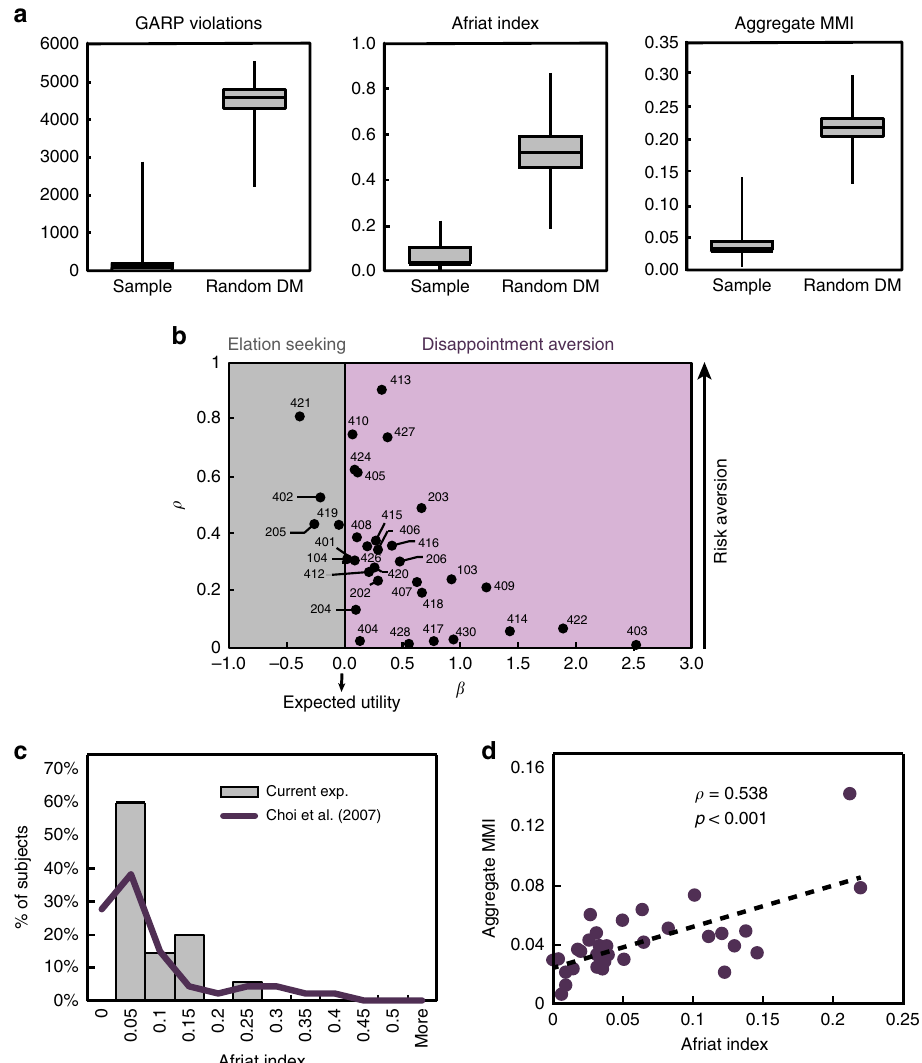
Fig. 3 Behavioral results. a Actual subjects vs. random subjects: In our sample, the median number of GARP violations was 59 (std = 506.24, min = 1, lower quartile = 11, upper quartile = 166, max = 2873), the median Afriat index was 0.0362 (std = 0.058, min = 0.0007, lower quartile = 0.0258, upper quartile = 0.1011, max = 0.2197), and median Aggregate MMI score was 0.037 (std = 0.0242, min = 0.0065, lower quartile = 0.0297, upper quartile = 0.0481, max = 0.143). Both the aggregate MMI and Afriat index range between 0 (fully consistent) and 1. For comparison, 25,000 simulations of random decision-makers yielded median number of GARP violations of 4,568.5 (std 397.6, min = 2216, lower quartile = 4294, upper quartile = 4794, max = 5565), a median Afriat Index of 0.5229 (min = 0.182, lower quartile = 0.4545 upper quartile = 0.5905, max = 0.872) and a median Aggregate MMI of 0.2186 (min = 0.1332, lower quartile = 0.2047, upper quartile = 0.2326, max = 0.299). These high scores indicate that our subjects did not choose randomly along the budget lines. b Recovered parameters using the MMI with the Disappointment Aversion (DA) utility function with Constant Relative Risk Aversion (CRRA) functional form 69 (see Methods). The β and ρ parameter estimates for each subject are plotted. When β < 0 ( “ elation seeking ” , four subjects, gray area), the subject overweights the higher prize. When β < 0 ( “ disappointment aversion ” , 29 subjects, purple area), the subject overweights the lower prize. Higher ρ values represent higher risk aversion levels. When β < 0, it is the case of the common Expected Utility (if, in addition, ρ = 0, it is the special case of Expected Value). c Comparison with lab experiments: Distributions of Afriat index of our subjects compared with Choi et al. 13 . d Validity of MMI. Correlation of Afriat index with Aggregate MMI ( ρ = 0.538, p < 0.001, n =